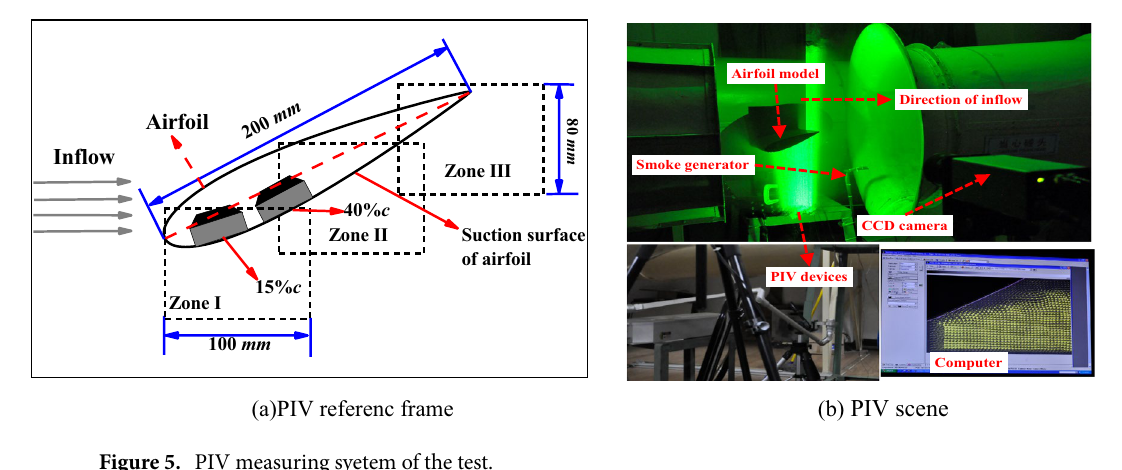
Figure 5. PIV measuring syetem of the